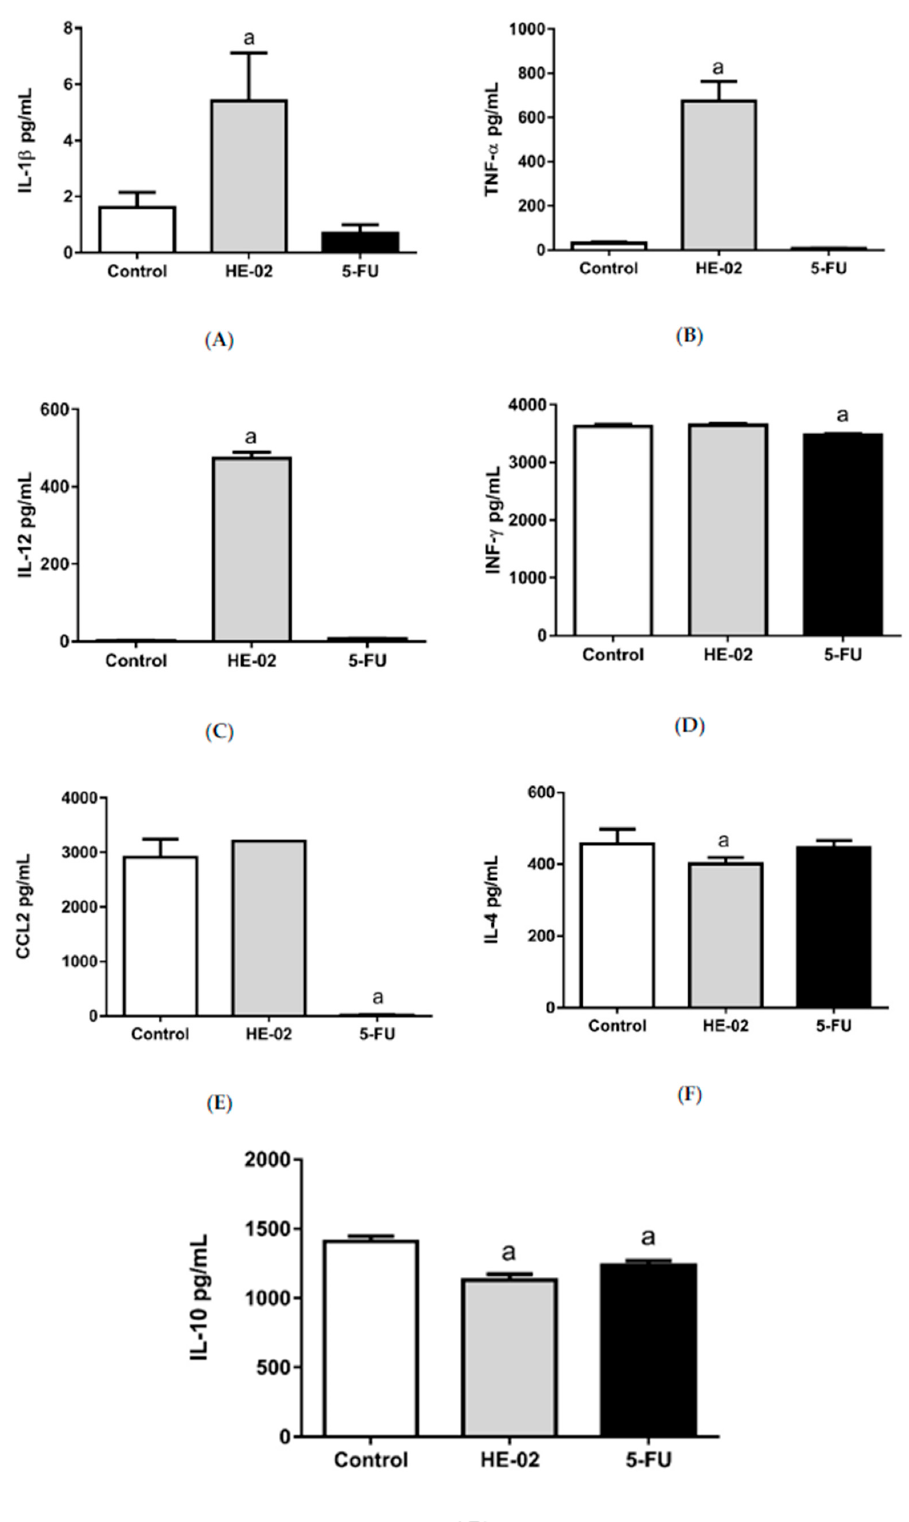
Figure 4. Effect of HE-02 (12.5 mg/kg) and 5-FU (25 mg/kg) on the levels of IL-1 β ( A ), TNF- α ( B ), IL-12 ( C ), INF- γ ( D ), CCL2 ( E ), IL-4 ( F ) and IL-10 ( G ) in the peritoneal lavage of Ehrlich ascites carcinoma transplanted mice. Data presented as mean ± SEM of six animals analyzed by ANOVA followed by Tukey test. a p < 0.05 compared to tumor control group.